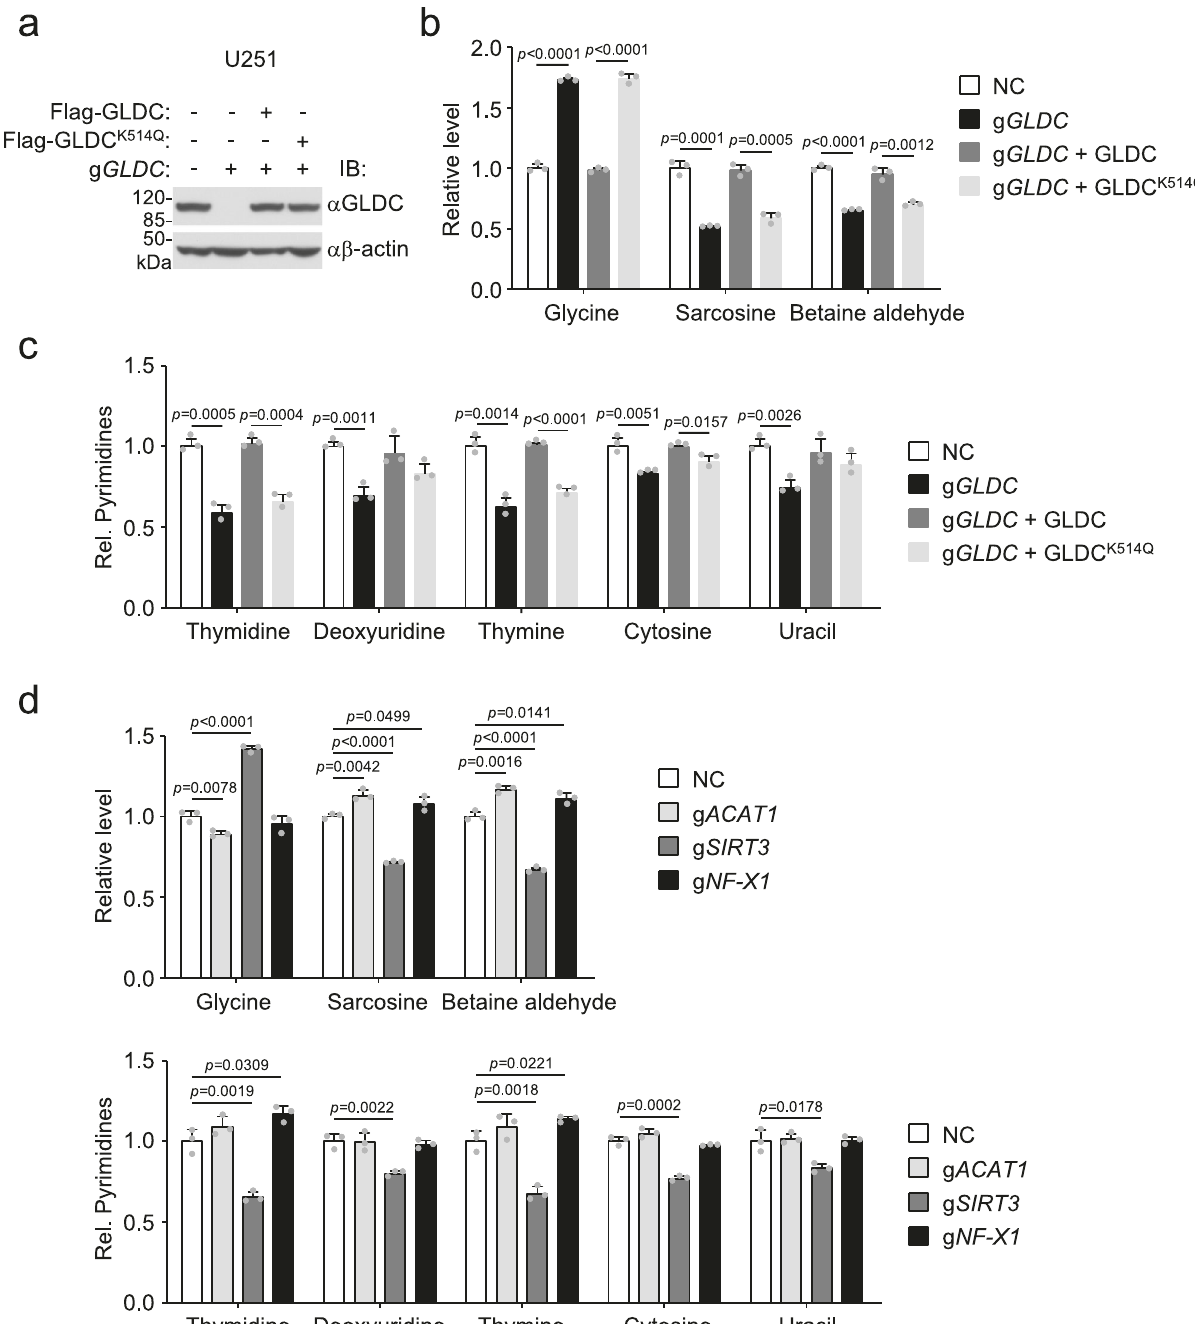
Fig. 8 GLDC K514 acetylation inhibits glycine catabolism and pyrimidine synthesis. a – c Reconstitution of GLDC-de fi cient U251 cells with wild-type GLDC or GLDC K514Q . Lysates of the indicated cells were analyzed by immunoblots with the indicated antibodies ( a ). The control and reconstituted cells were analyzed for levels of glycine and glycine-related metabolites ( b ) and pyrimidines ( c ) by LC-HRMS. Graph shows mean ± SEM, n = 3 technical repeats. Data were analyzed using two-way ANOVA with GraphPad Prism 7. d Effects of ACAT1, SIRT3, or NF-X1 de fi ciency on cellular levels of glycine, glycine-related metabolites, and pyrimidines. Levels of glycine and its metabolites in the indicated cells were measured by LC-HRMS. Graph shows mean ± SEM, n = 3 technical repeats. Data were analyzed using two-way ANOVA with GraphPad Prism 7. Source data are provided as a Source data fi